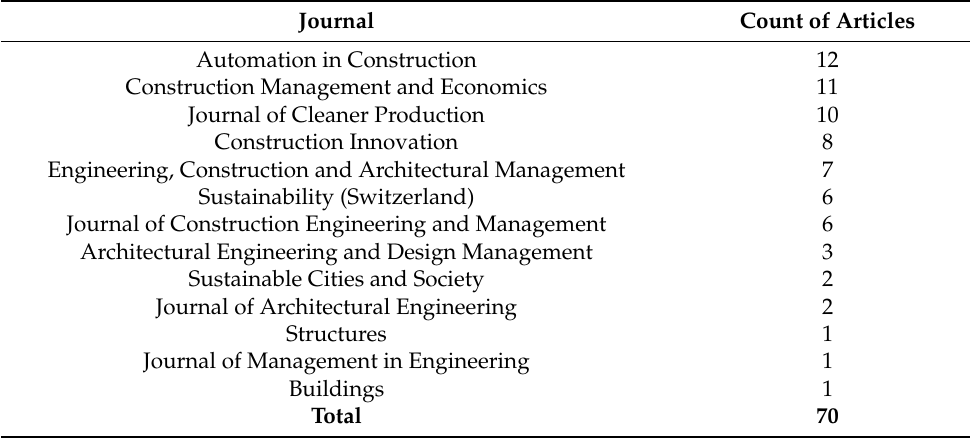
Table 3. Number of articles against the peer-reviewed